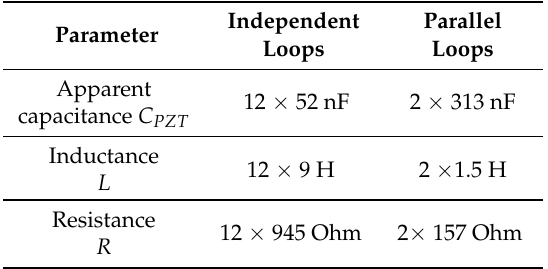
Table 2. Shunt circuit parameters for damping the mode with three nodal diameters ( Ω 3 = 223 Hz).